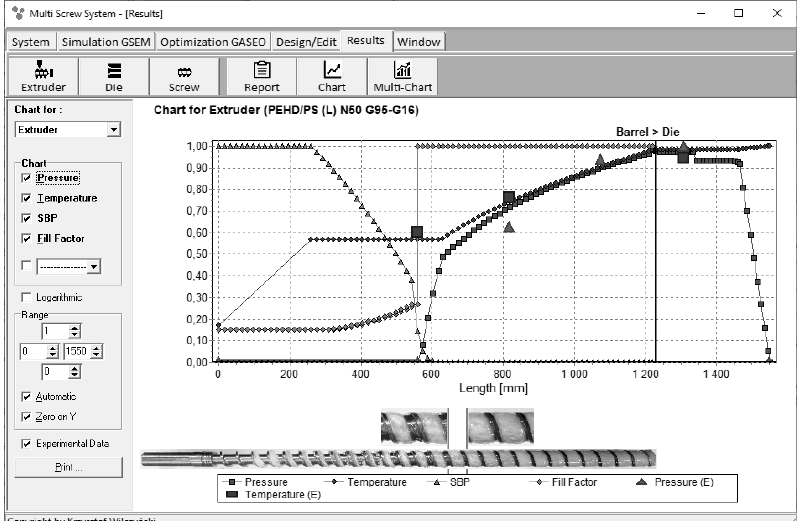
Figure 4. Overall extrusion characteristics, simulation and experimentation data using the GSEM model—starve fed single screw extrusion: SBP—solid bed profile, E—experiment [68].